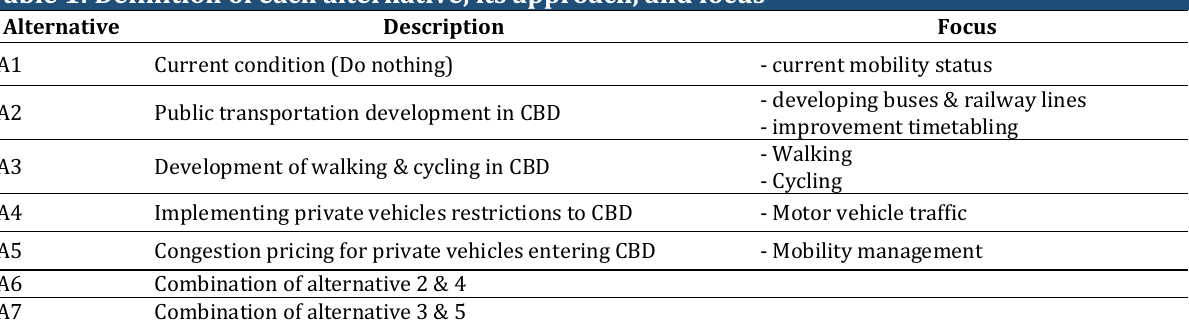
Table 1: Definition of each alternative, its approach, and focus